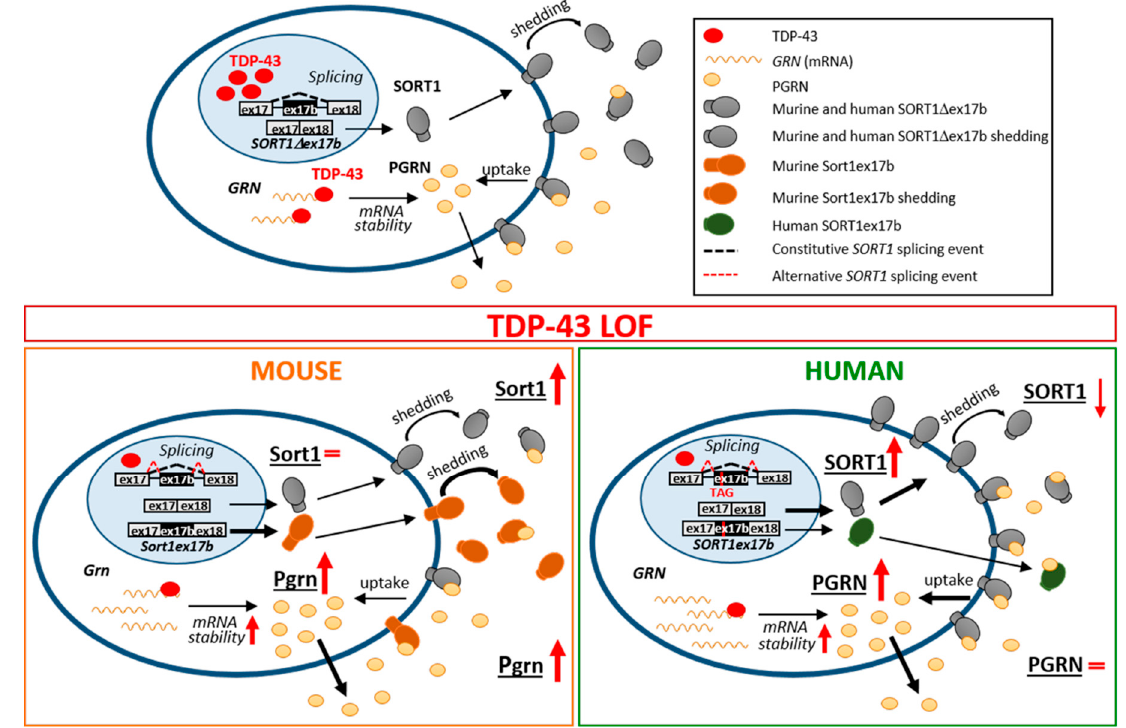
Figure 6. Proposed model for TDP-43 LOF effects on the PGRN–SORT1 axis in murine and human neuronal cells. In the nucleus, TDP-43 represses the inclusion of SORT1ex17b , an intronic exon cassette, while, in the cytoplasm, it binds to the Progranulin 3 ′ UTR, decreasing its mRNA stability (upper panel). In the condition of TDP-43 LOF, intracellular progranulin protein increases in both cell models, while the secreted levels are upregulated in murine cells and unchanged in human ones (lower panels). We speculate that this difference is due to TDP-43-dependent regulation of gene expression and splicing of the Sortilin gene. Loss of TDP-43 promotes the inclusion of SORT1ex17b . While this alternative splicing event becomes prevalent in mice with the synthesis of a functional isoform more prone to shedding and to be released (left panel), it is rare in humans where the resulting isoform is instead truncated and not anchored to the membrane [21] (right panel). Moreover, in human cells, the observed increase of intracellular SORT1 protein (soluble and transmembrane) is likely to favor PGRN uptake, thus accounting for the differences in progranulin bioavailablity between mice and humans. Arrow thickness indicates upregulated or downregulated events compared to the physiological condition in the upper panel; red arrows indicate TDP-43 LOF effects.